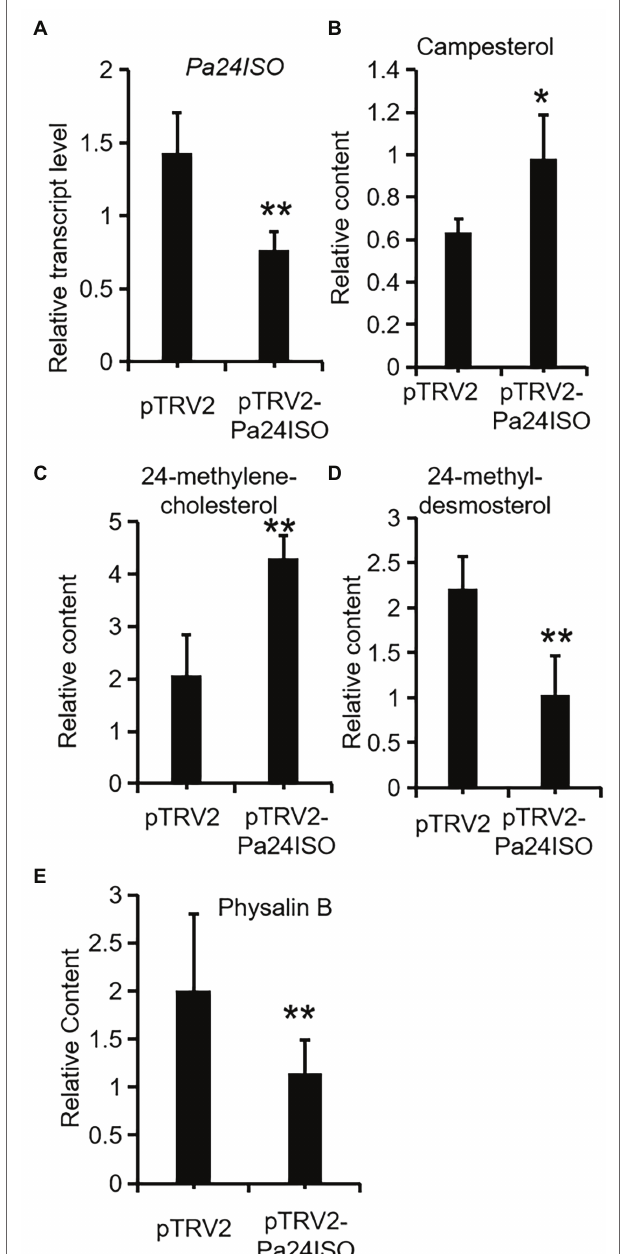
FIGURE 5 | Downregulation of Pa24ISO resulted in reduced physalin B levels in P. angulata . The Pa24ISO -silenced plants (pTRV2-Pa24ISO) were compared to the empty vector-transferred plants (pTRV2), in analysis of expression of Pa24ISO (A) , and the relative abundances of campesterol (B) , 24-methylenecholesterol (C) , 24-methyldesmosterol (D) , and physalin B (E) . The error bars represent ± SE of three or six independent experiments (** p ≤ 0.01, * p ≤ 0.05; student t